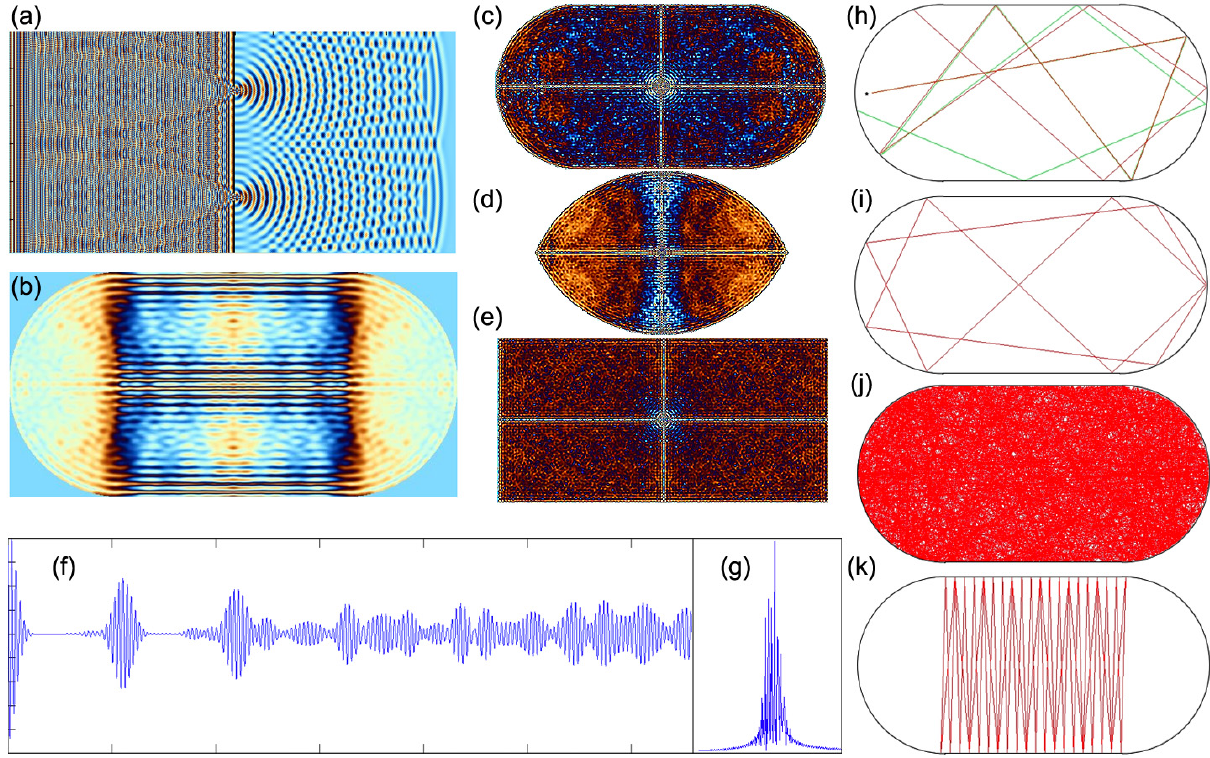
Figure 7: (a) A modification of the rectangular potential well consists of a discrete model of a double slit interference experiment, showing the cellular automaton well models circular wave fronts emerging from a double slit and forming constructive and destructive interference fringes. (b) A vertical wave generator produces an ordered wave function on the stadium. (c-e) Probability distributions for a circular wave packet of period a fraction of the overall dimensions for 3300 iterations for the stadium (c), lemon (d) and rectangle (e) display the di ff erences between chaotic and ordered wave forms. (f) Autocorrelation function of the generated bow tie scar in panel (b) of Figure 3. (g) Fast Fourier transform giving frequency domain. (h-k) Classical orbits in the stadium display the classic features of chaotic billiards. (h) Sensitive dependence on initial conditions illustrated for two closely related initial conditions (red and green) show exponentiating divergence with each reflection. Chaos also causes the space to be densely permeated with repelling periodic orbits, two of which are illustrated in (i) and (k). Because they are repelling, neighboring orbits are thrown further away, rather than being attracted into a stable periodic orbit as in an ordered system. Consequently almost all orbits are recurrent and densely fill phase space